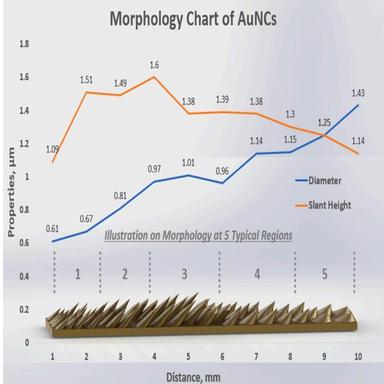
Schematic graph of the average slant height and diameter of AuNPs at different distances from the graphite plate (carbon source), and an illustration of morphological features in the 5 typical regions.